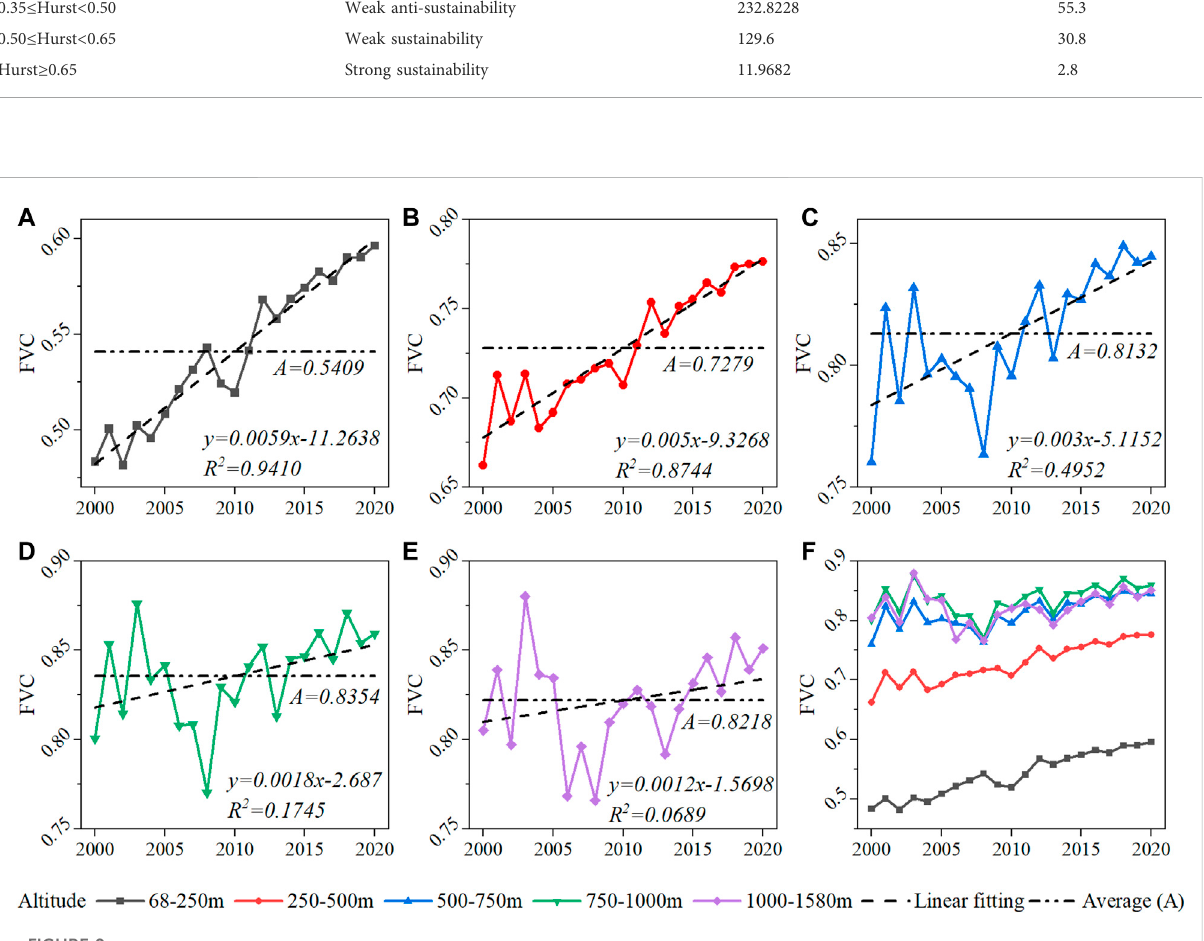
FIGURE 9 Evolution characteristics of vegetation coverage with increase in altitude in the upper reaches of Ganjiang River Basin from 2000 to